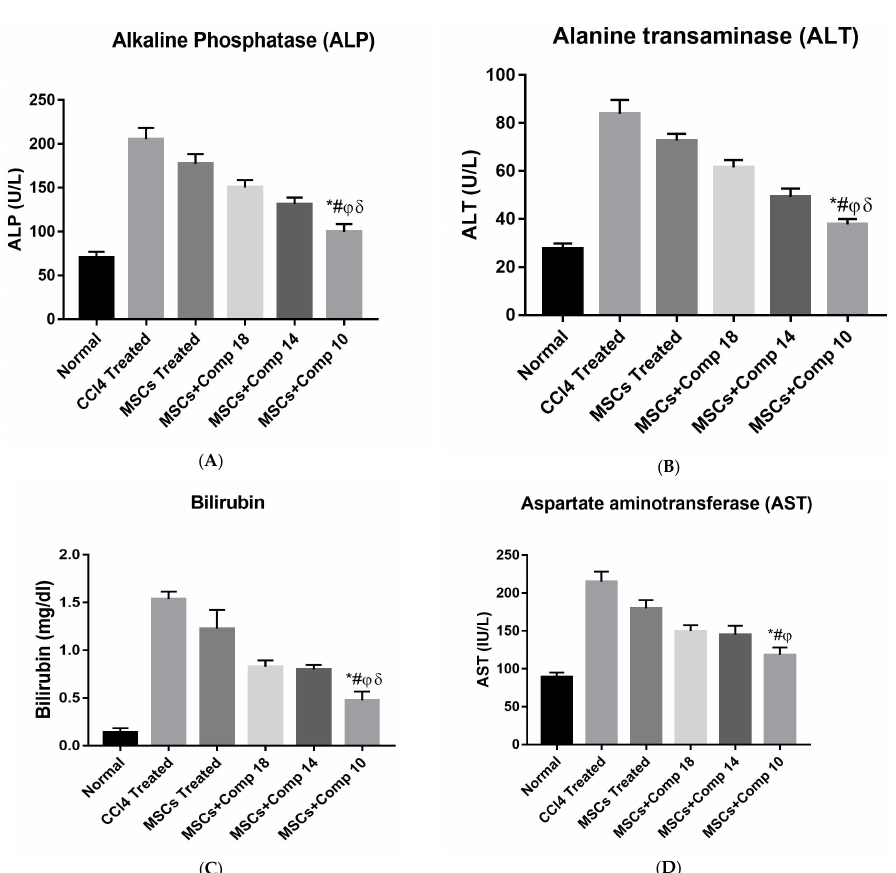
Figure 9. Liver function tests after MSCs + compounds transplantation : ( A ) alkaline phospha ‐ tase; ( B ) alanine transaminase; ( C ) bilirubin; ( D ) aspartate aminotransferase levels in all experimental models after 2 weeks of transplantation. p value < 0.05 was considered significant. MSCs + compounds ( 10 ) ‐ transplanted animals show a greatly reduced enzymes level, shown by bars with the symbol ( * ). * p < 0.05 for MSCs+Comp10 vs. CCl4; # p < 0.05 for MSCs + Comp10 vs. MSCs; φ p < 0.05 for MSCs + Comp10 vs. MSCs+Comp18; δ p < 0.05 for MSCs + Comp10 vs. MSCs + Comp18.